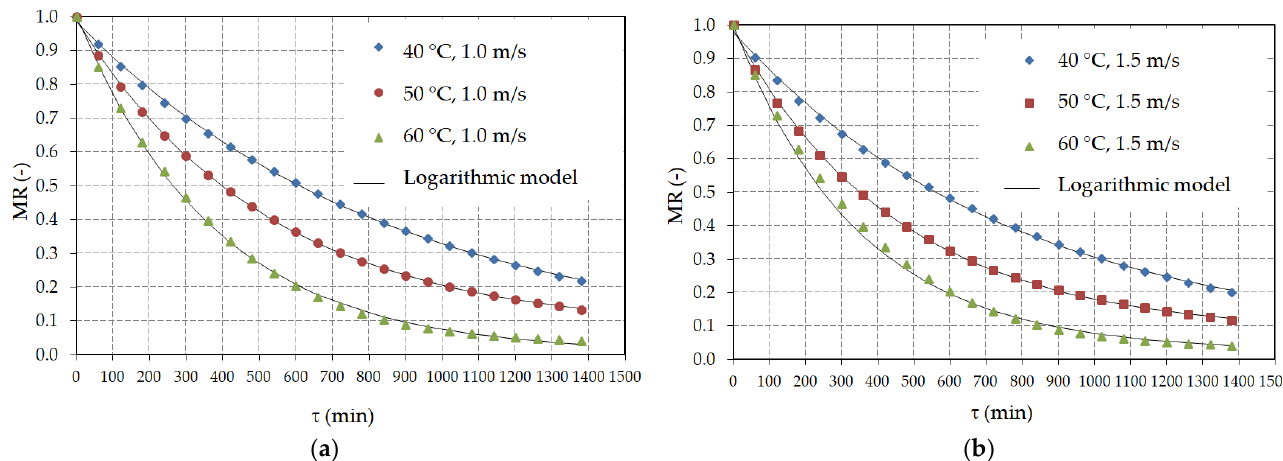
Figure 5. Drying curves of the hot air drying process of the apricot halves with osmotic pretreatment OD2 (60 °C, 65%): ( a ) air velocity 1.0 m/s, ( b ) air velocity 1.5 m/s.